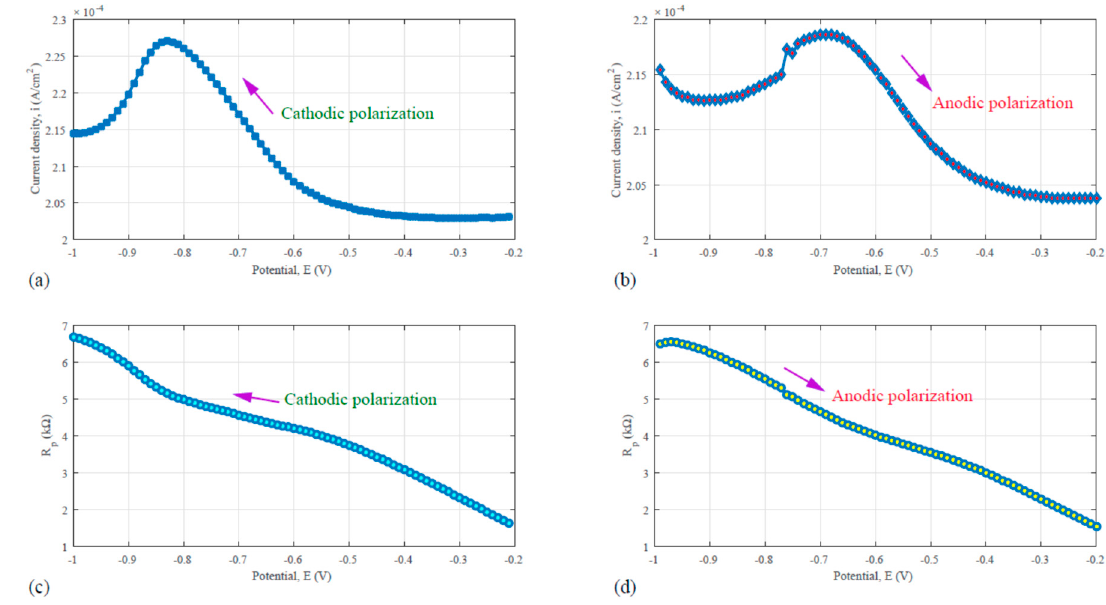
Figure 9. AC voltammograms and electrochemical impedance plots of the 6061-T6 aluminum alloy in 0.1 N sulfuric acid: ( a ) Voltammogram generated by the cathodic polarization (downward sweep), ( b ) voltammogram generated by the anodic polarization (upward sweep), ( c ) impedance versus scanning potential in the cathodic polarization, and ( d ) impedance versus scanning potential in the anodic polarization.